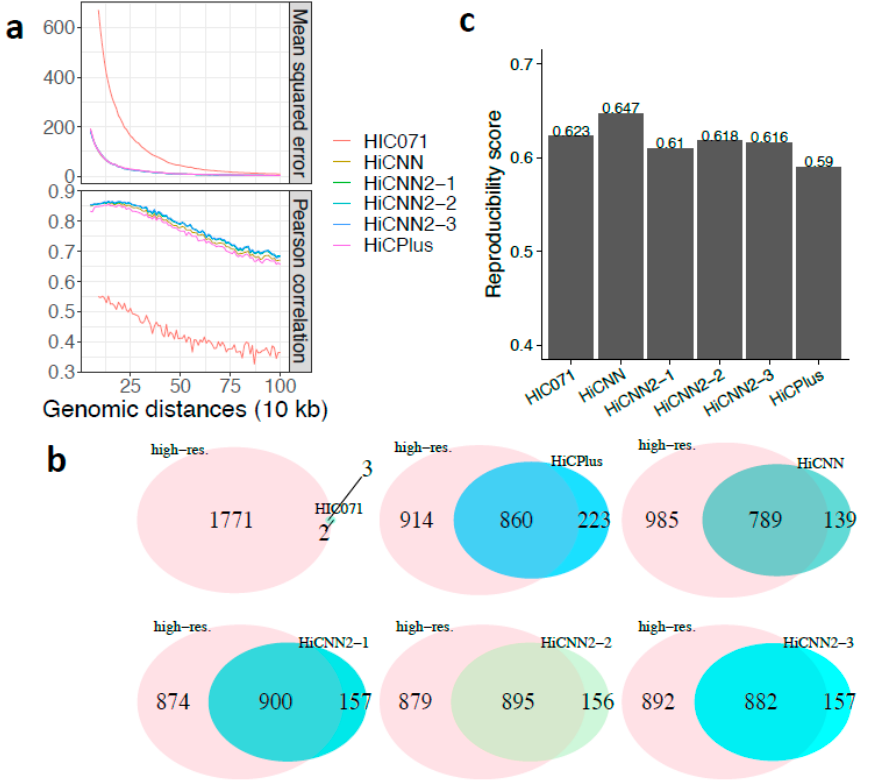
Figure 6. The evaluation results on chromosome 18 of human K562 cells between experimental high-resolution Hi-C (10 kb resolution) and each of the six Hi-C data sets, namely, real low-resolution (HIC071) from Aiden lab, HiCPlus-enhanced, HiCNN-enhanced, HiCNN2-1-enhanced, HiCNN2-2-enhanced, and HiCNN2-3-enhanced Hi-C data, with a down-sampling ratio of 1 / 16: ( a ) mean squared error and Pearson’s correlations; ( b ) the e ff ectiveness of recovering significant interactions (detected by Fit-Hi-C with q -value < 0.05 within the genomic distances from 50 kb to 2 Mb); and ( c ) the reproducibility scores.